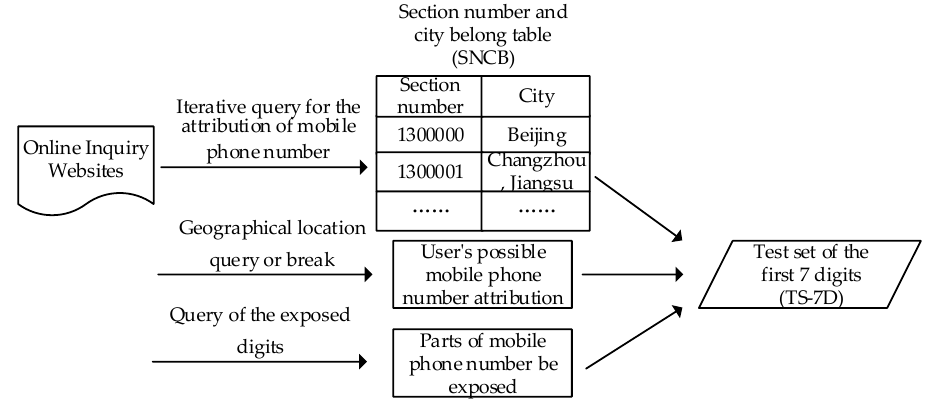
Figure 3. The construction process of the test set of the first seven digits (TS-7D).